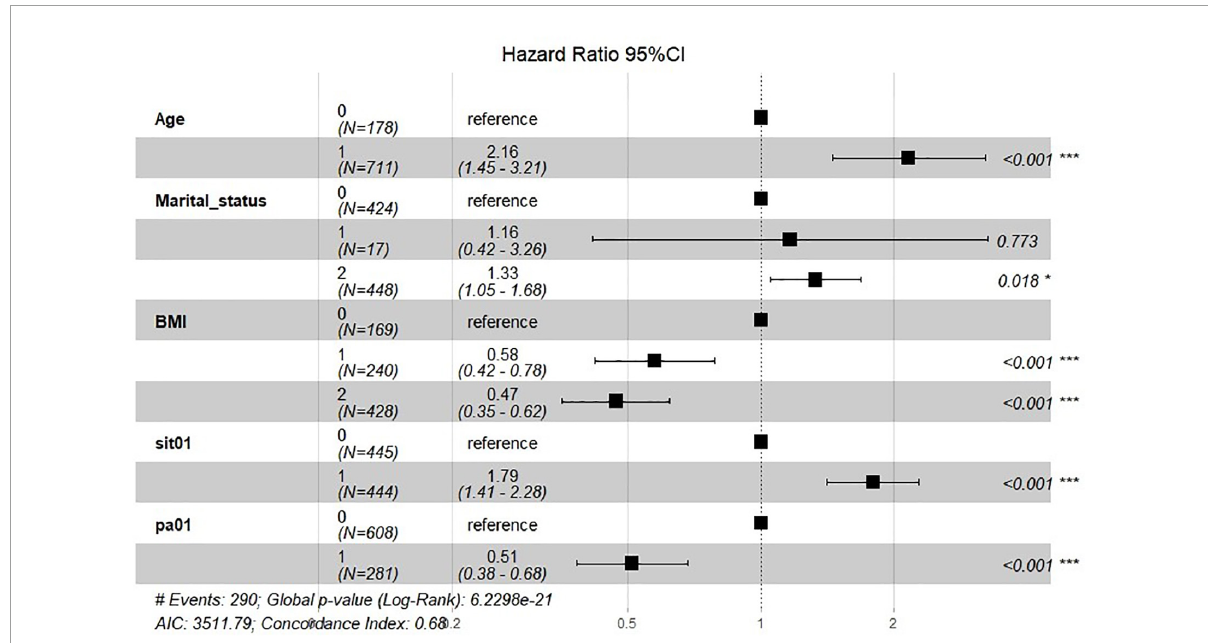
FIGURE2 Forest-plot for multivariate Cox regression associated with all caused death. Age = “0” represents 20–59 years, “1” represents 60–85 years. Marital status = “0” represents married, “1” represents living with partner, and “2” represents others. BMI = “0” represents BMI < 25, “1” represents 20–25, and “2” represents BMI ≥ 25. Sit01 = “0” represents no sedentary behavior while “1” represents group with sedentary behavior. Pa01 = “0” represents no physical activity while “1” represents group with physical activity. * P < 0.05; *** P <